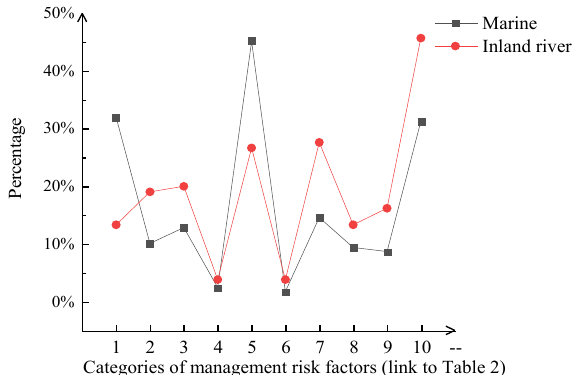
Figure 8. Proportion of Sub-Factors of Marine and Inland River Environmental Factors.